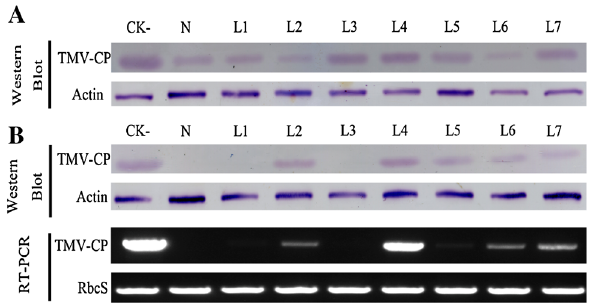
Fig. 3 a Western-blot analysis of accumulation of TMV coat protein in the inoculated leaves treated with lycoricidine derivatives ( L1 – L7 ) (100 l g/mL) at 3 dpi. b Western-blot and RT-PCR analysis of accumulation of TMV coat protein in system leaves at 5 dpi. CK - negative control, N ningnanmycin, Actin and RbcS serves as internal reference